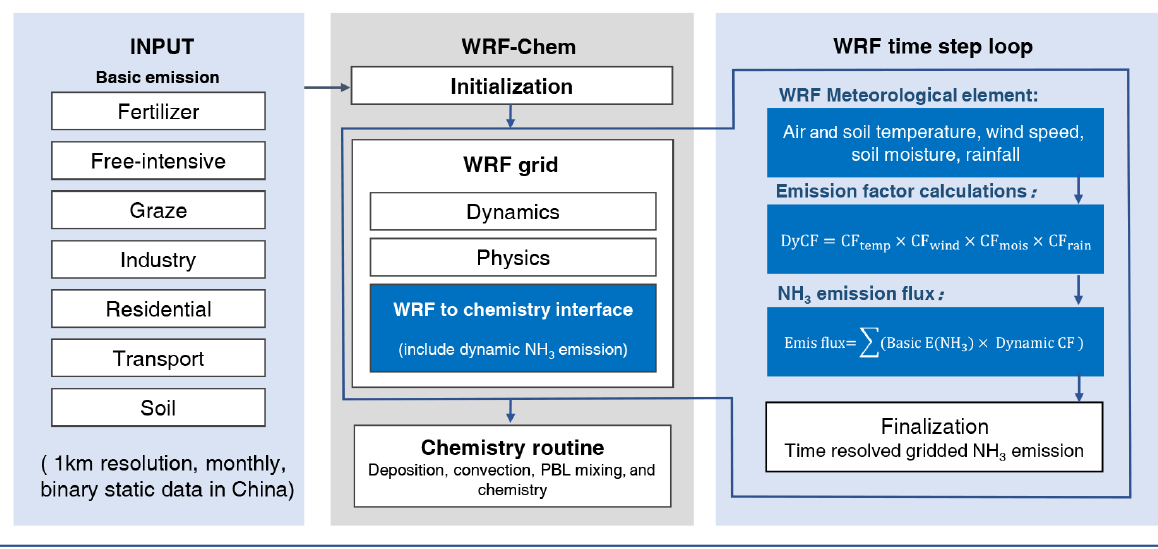
Figure 1. Architectural overview of the WRF–SoilN–Chem model (v1.0). The NH 3 emission flux calculation (all parts shown in blue) includes basic emission data and dynamic calculation. The parent model WRF–Chem (shown in gray) displays standard codes downloaded from their sources, without any